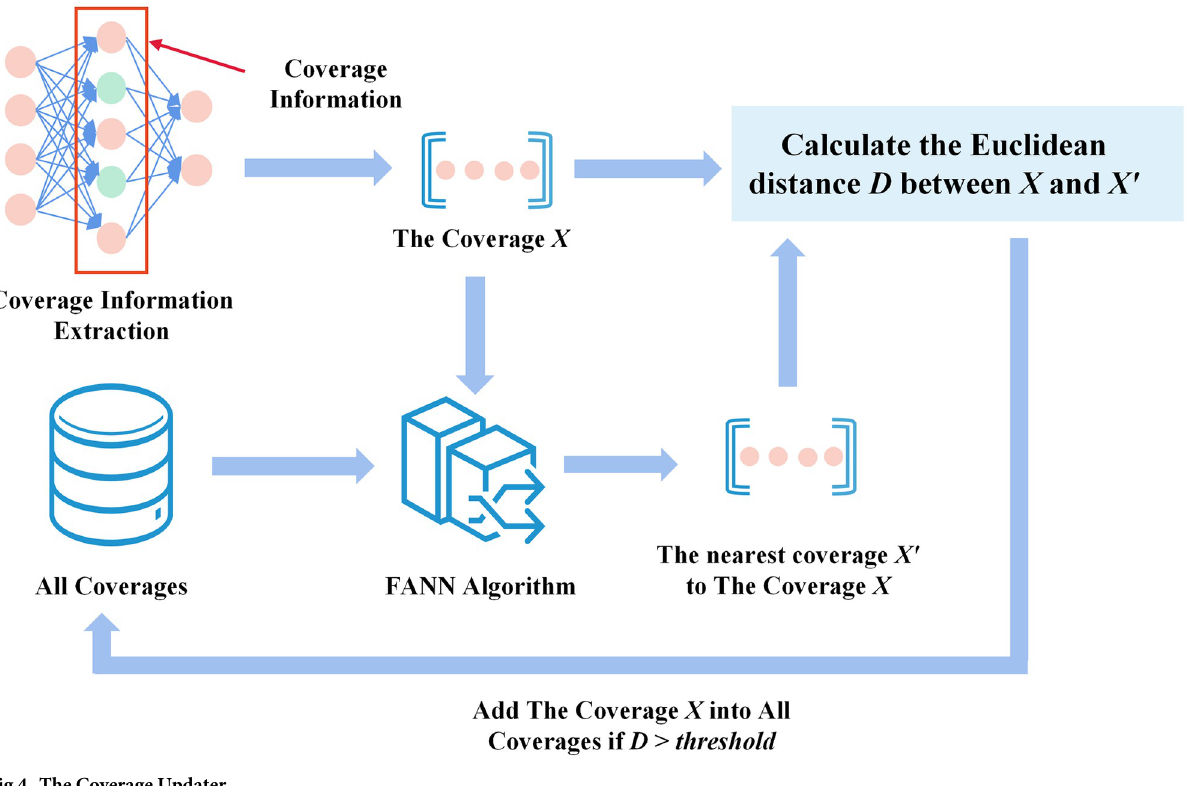
Fig 4. The Coverage